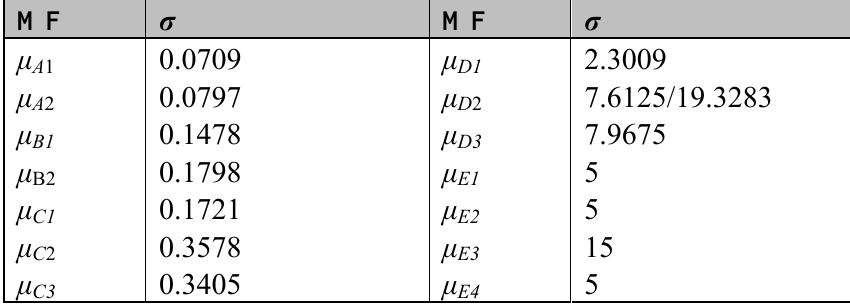
Table 3. Standard deviation σ for each membership